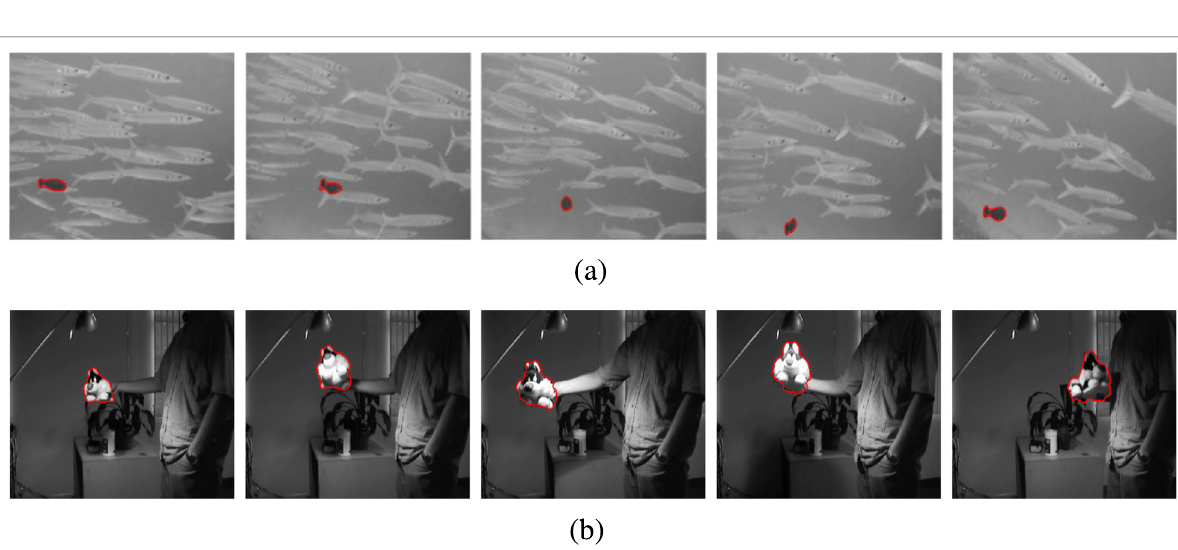
Fig. 9 Experimental results of evaluation on gray scale video sequences. a Tracking results of the proposed method on fish sequence for frames of 48, 162, 196, 299, and 355. b Tracking results of the proposed method on toy dog sequence for frames of 231, 270, 361, 383, and